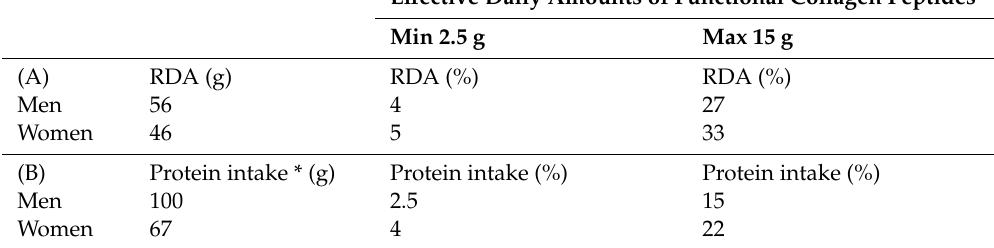
Table 4. Effective daily amounts of functional collagen peptides (2.5 to 15 g) observed in the literature, expressed as (A) percent of the Recommended Dietary Allowances (RDA) for both men and women and (B) percent of the average daily protein intake in the standard American diet*.